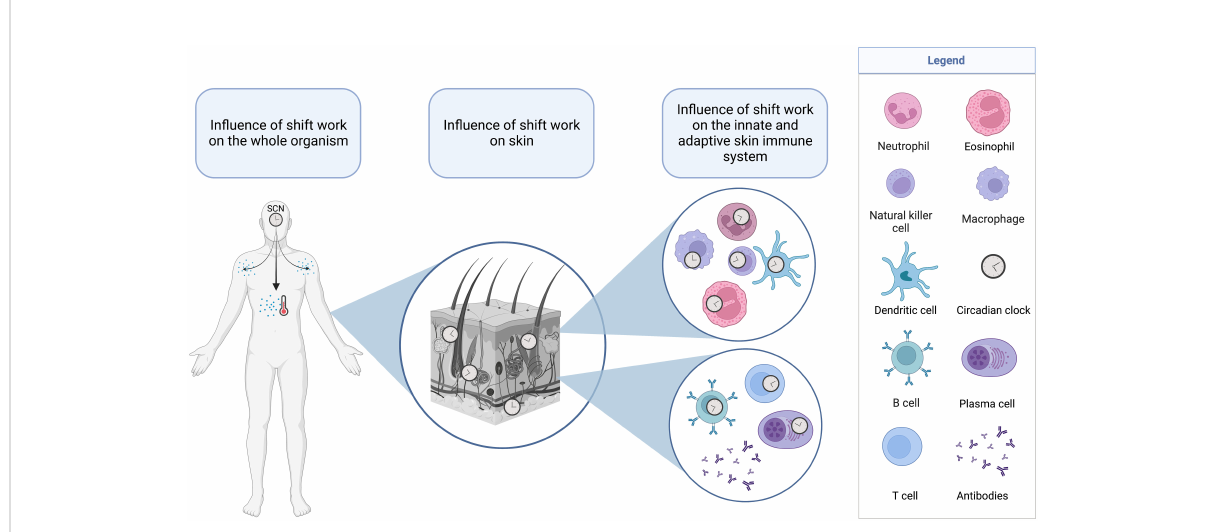
FIGURE 4 Layers of systems in the human body that are affected by shift work. Circadian disruptions due to shift work can affect the suprachiasmatic nuclei (SCN) and the major outputs of this master clock such as core body temperature and neuroendocrine mediators. These systemic in fl uences as well as direct effects of ambient temperature and light can affect the circadian system in the skin and the cellular clocks of skin leukocytes of the innate (top) and adaptive (bottom) immune